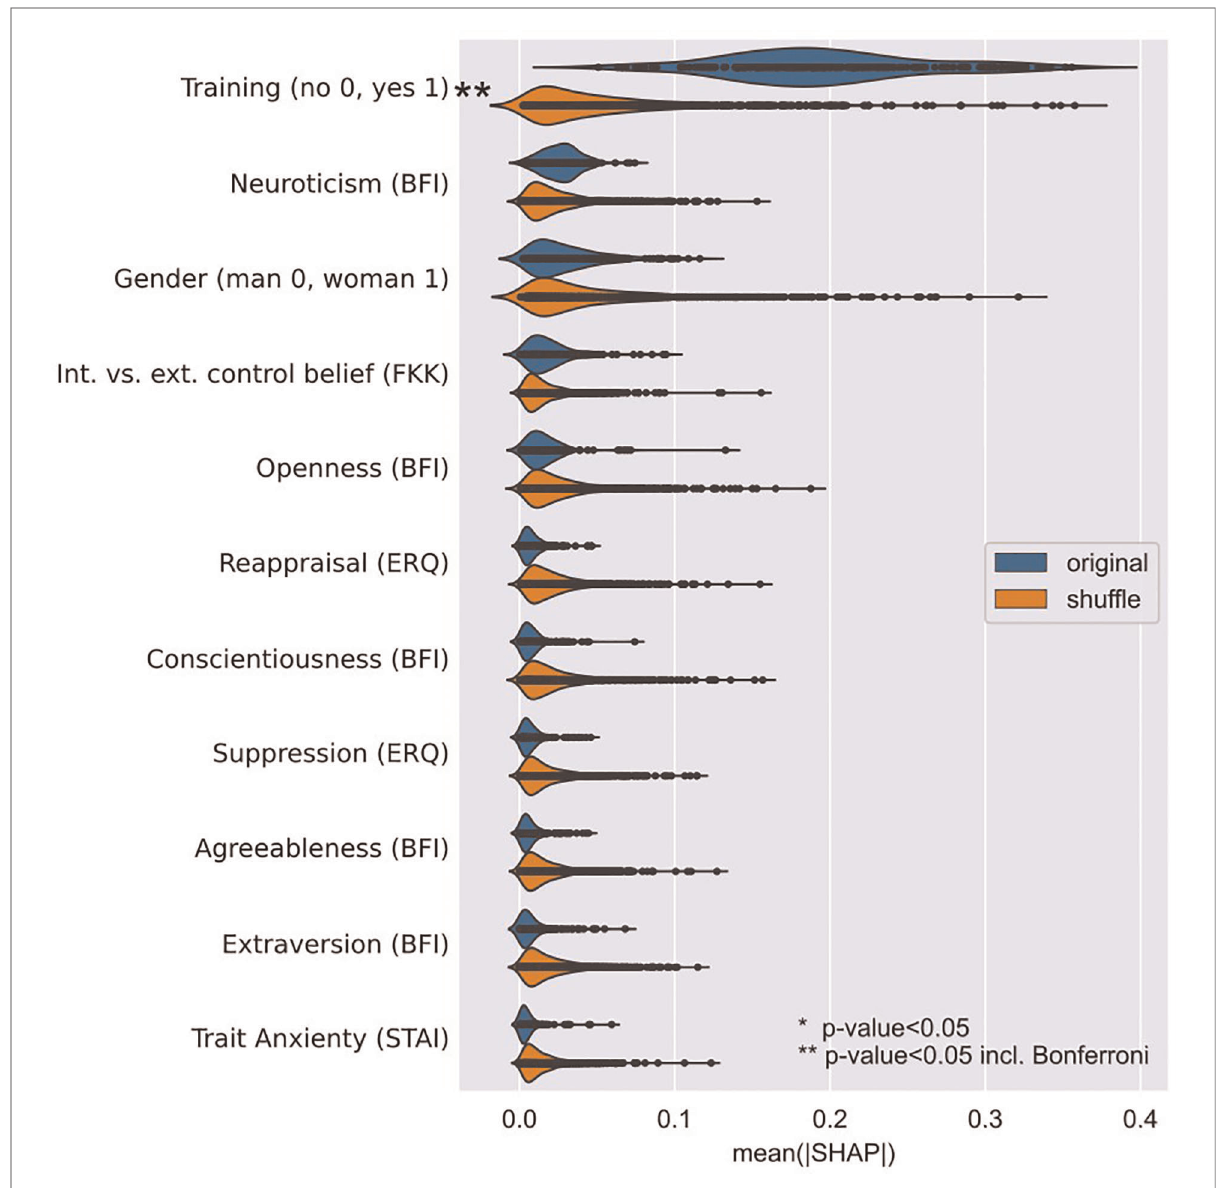
FIGURE 4 Importance of factors for the prediction of good/bad performer in the NLS scenario when using an extra trees (ET) classi fi